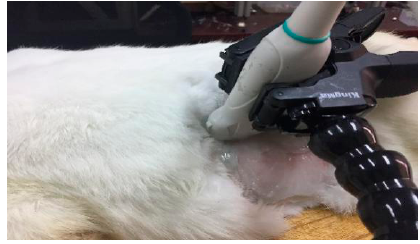
Figure 12. The in vivo rabbit experiment targeting the kidney.